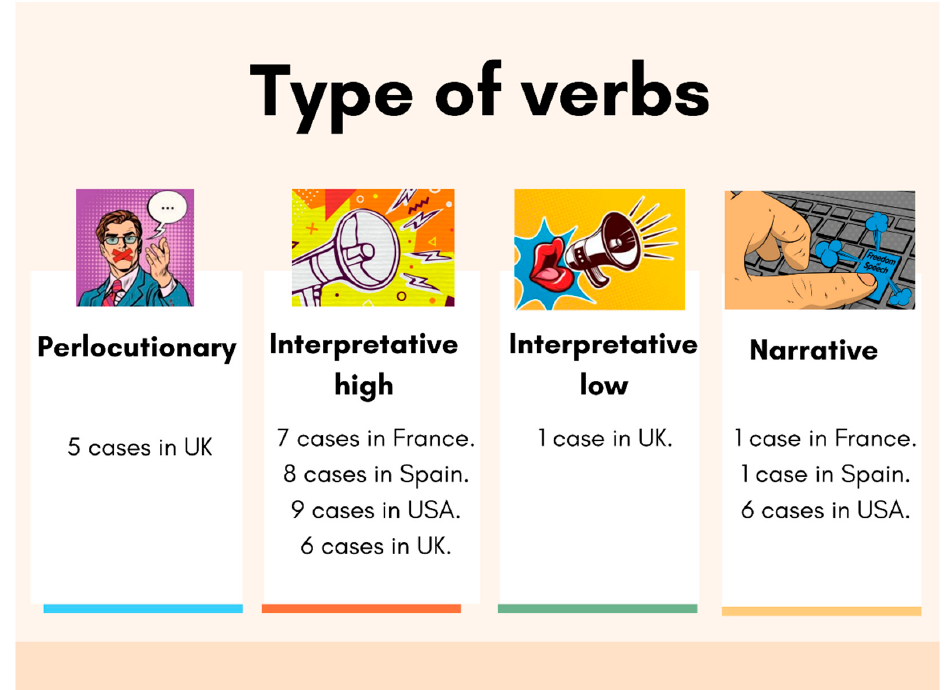
Figure 9. Analysis of vaccine’s verbs.